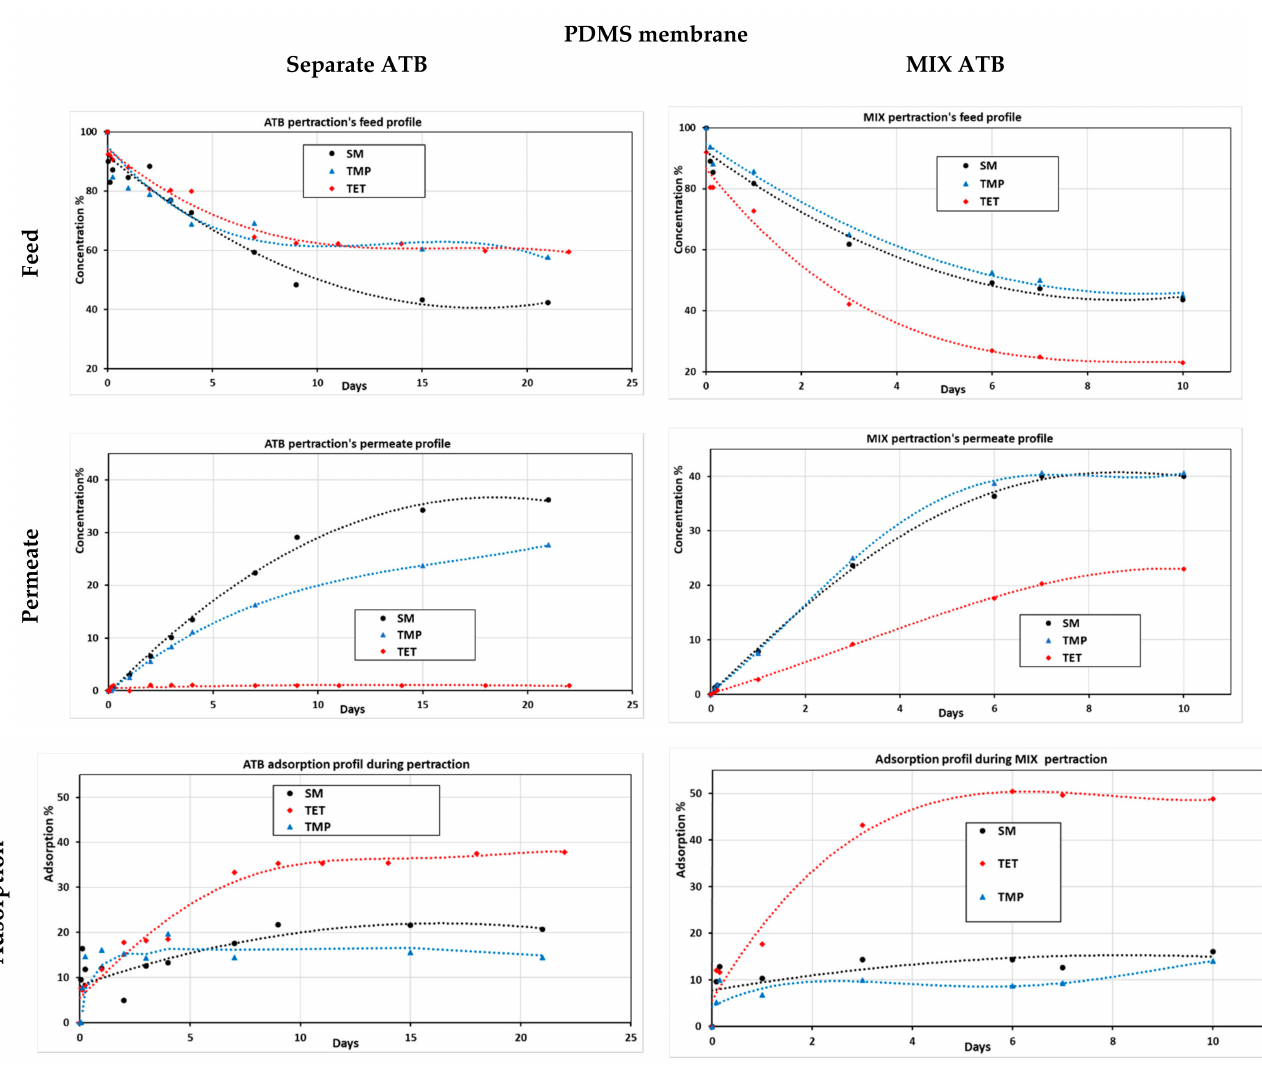
Figure 6. Adsorption, permeate, and feed profiles of both mixed and separated antibiotic solutions (sulfamethoxazole, trimethoprim, and tetracycline) of the pertraction process with a bare PDMS